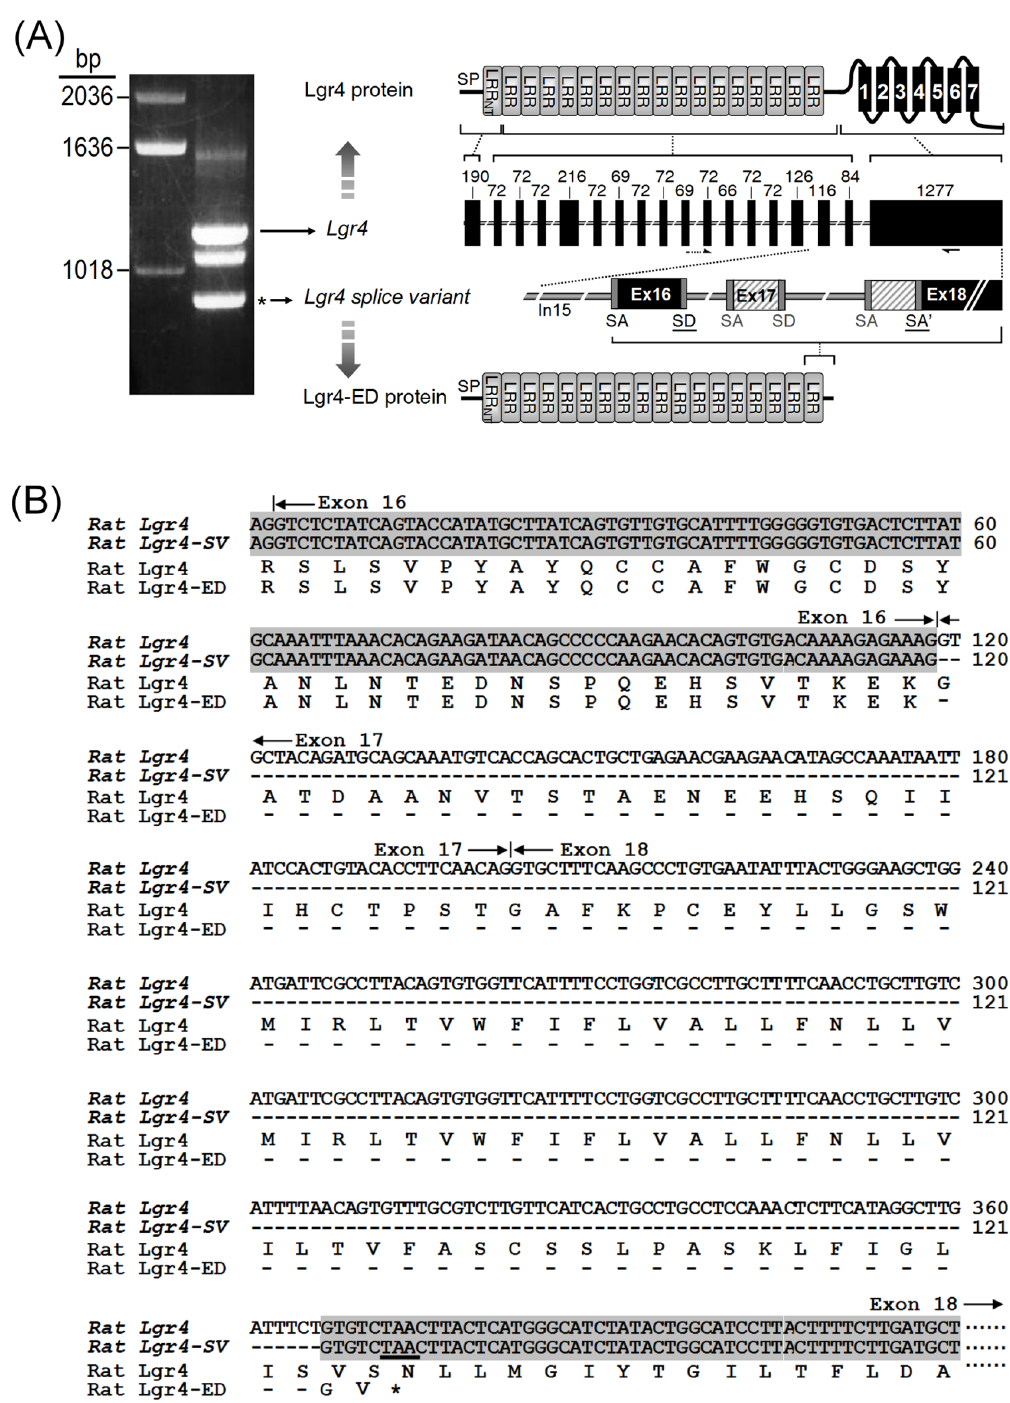
Figure 1. Gene structure of Lgr4 and the amino acid sequence of Lgr4-ED. (A) Cloning and gene organization of rat Lgr4 and rat Lgr4 splice variant. Left panel: both fragments of full-length Lgr4 and Lgr4 variant can be amplified from the mature rat ovarian cDNA by using a forward primer spanning exon 10 and 11 and a reverse primer in exon 18. Right panel: exons are represented by boxes ; introns are shown by the lines between exons. The numbers indicate the base pairs in each exon. Primer locations were indicated by arrows at the bottom of axons. The Lgr4 variant is spliced via selection of the splice donor (SD) site of exon 16 and an alternative splice acceptor (SA’) of exon 18; this results in the deletion of exon 17 and the initial 164 bps of exon 18 (slash boxes). The deduced domain structure from each exon of the full-length Lgr4 and Lgr4-ED proteins are shown. SP, signal peptide; LRRnt; leucine rich repeat N-terminal domain; LRR; leucine rich repeat domain; TM, transmembrane domain. (B) Comparison of nucleotide sequences and deduced amino acids between rat Lgr4 and rat Lgr4 splice variant ( SV ). Dashed lines indicate gaps introduced in the sequence for optimal alignment.